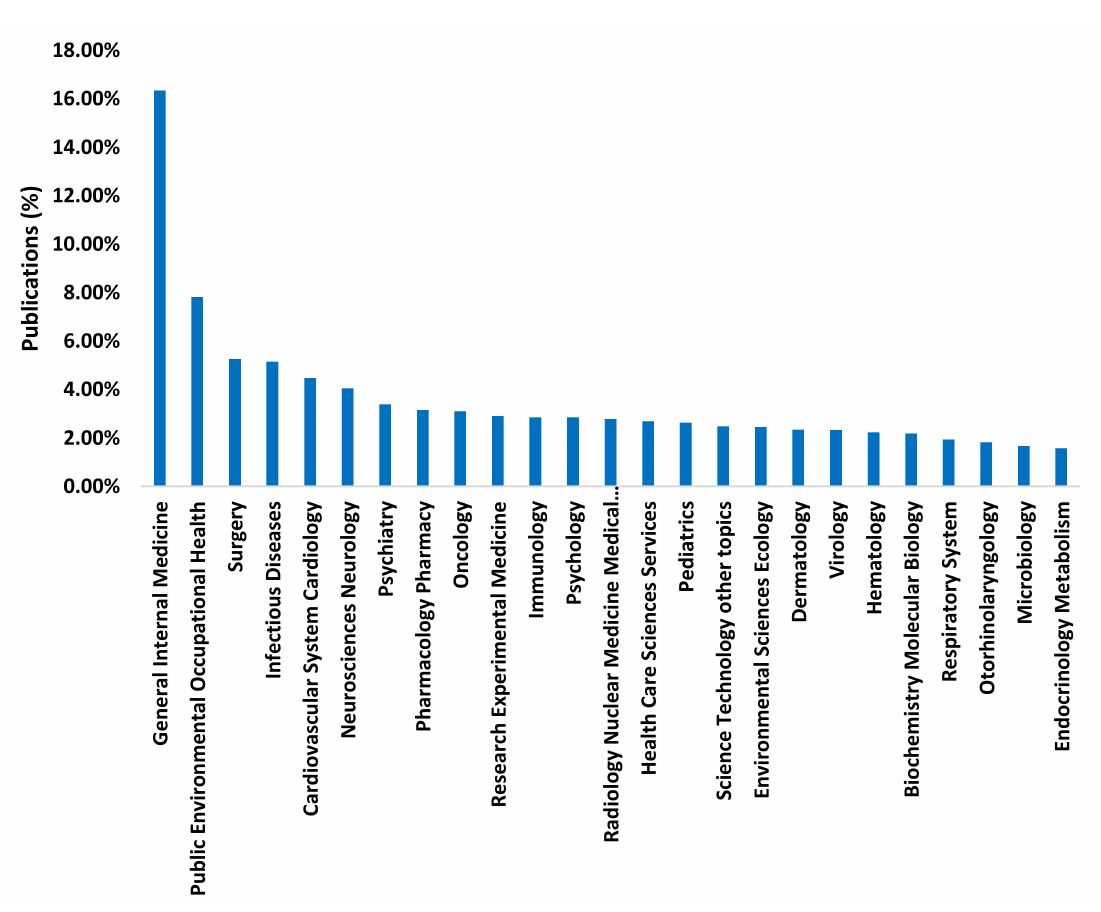
Figure 3. Percentage of publications by research